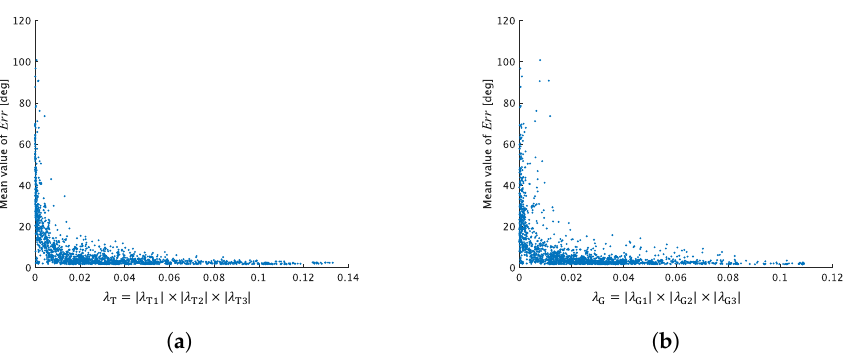
Figure 11. Product of three eigenvalues and mean value of reproduction error ( Err ) for 24 patches. ( a ) Eigenvalues were calculated from T designed under 24 C 3 combinations of three target colors. ( b ) Eigenvalues were calculated from G designed under corresponding ground truth